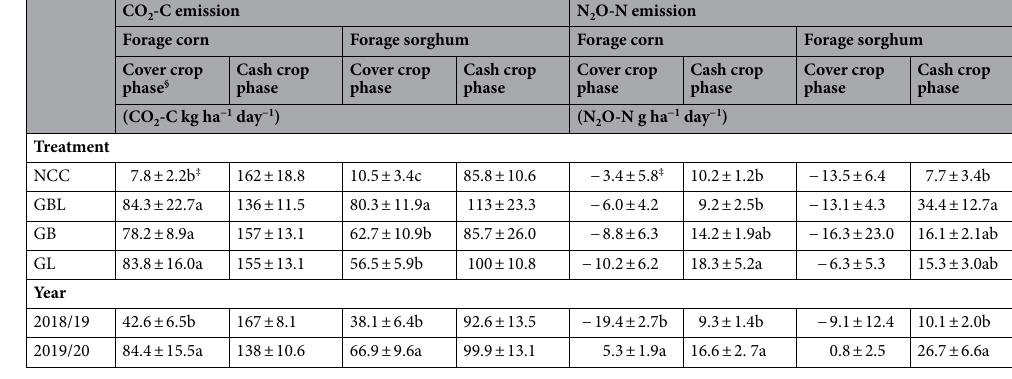
Table 1. Average CO 2 -C and N 2 O-N emissions under diverse cover crop treatments from 2018 to 2020. NCC no cover crops control, GBL grasses, brassicas, and legumes mixture, GB grasses and brassicas mixture, GL grasses and legumes mixture where grasses include annual ryegrass and triticale, brassicas include daikon radish and turnip, and legumes include berseem clover and winter pea. ‡ Mean values (± standard error) followed by different lowercase letters in a column indicate significant differences among cover crop treatments or between years ( p ≤ 0.05, LSD test). § In the 2018/19 cropping year, the cover crop phase represented